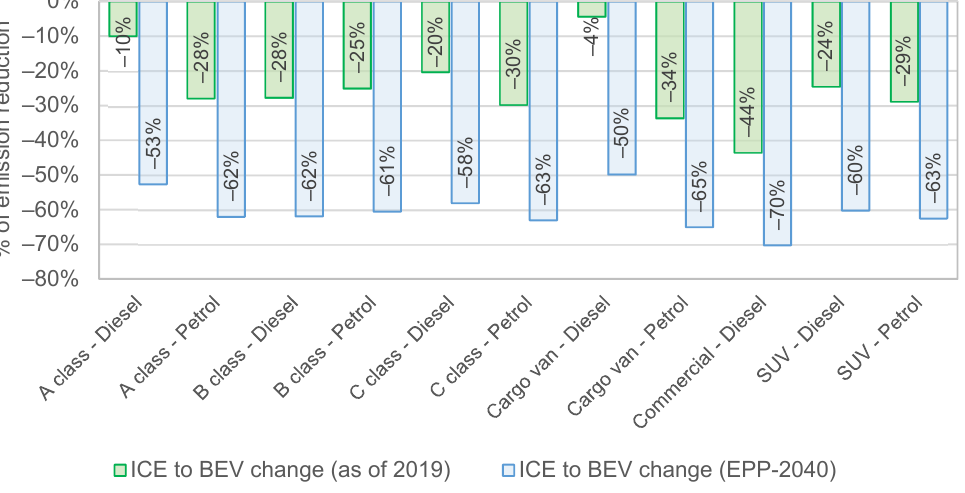
Table 4. Operational costs and savings analysis for ICE to BEV conversion.